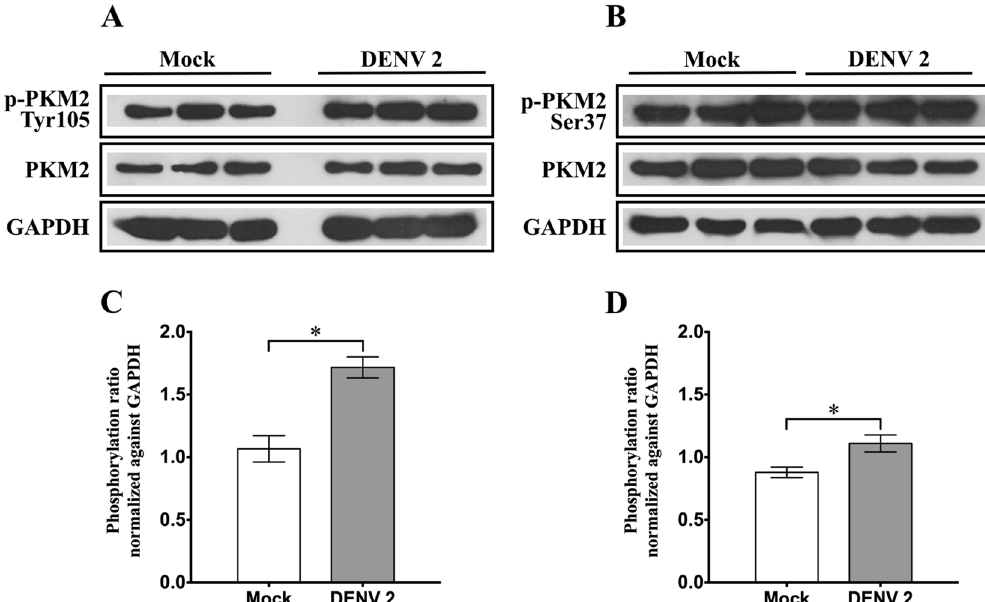
Figure 3. Western blot analysis of phosphorylated pyruvate kinase M2 at amino acid tyrosine 105 (Tyr105) and serine 37 (Ser37). U937 mock infected and DENV 2 infected cells were collected at 48 h. The cell lysates were prepared which were subjected to SDS-PAGE and western blot analysis to detect the expression of ( A ) p-PKM2 Tyr105 and ( B ) p-PKM2 Ser37 as well as ( A , B ) total PKM2 and glyceraldehyde-3-phosphate dehydrogenase (GAPDH). The experiment was performed independently in triplicate. ( C , D ) Protein band intensities were quantitated using the ImageJ image analysis program and analyzed by GraphPad Prism 5 program and the expression of all proteins were normalized to GAPDH. Error bars show mean +/- SEM of three experiments performed in triplicate. Data were analyzed by Unpaired t-test; * P < 0.05.